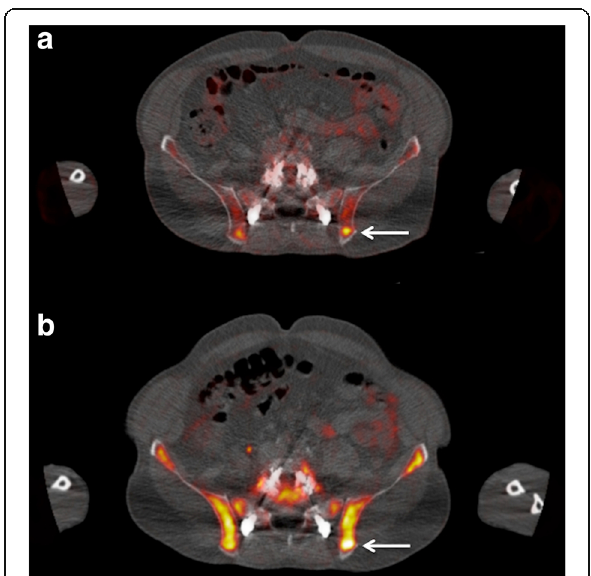
Fig. 3 Transaxial 18 F-FDG PET/CT ( a ) and 18 F-FLT PET/CT ( b ) images at the pelvic level of a 65-year-old male patient with initial diagnosis of MM. Focally increased 18 F-FDG accumulation (arrow, a ) in the left iliac bone, reflecting an active MM lesion (SUV mean =5.1, SUV max =7.2). 18 F-FLT PET/ CT also demonstrates focally enhanced tracer accumulation in the same anatomical site (arrow, b ), higher than the normal bone marrow uptake (SUV mea n =14.1, SUV max =16.8). Notice the physiologically increased 18 F-FLT bone marrow uptake rendering evaluation of skeletal lesions challenging (reference SUV mea n =6.5, SUV max